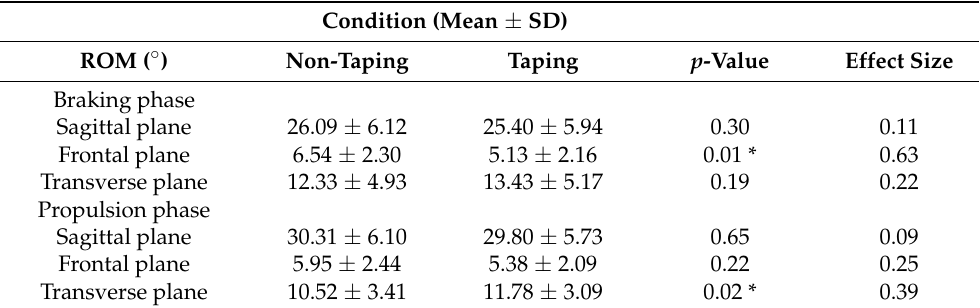
Table 2. Knee ROM of Braking and Propulsion Phases in Three Different Planes.